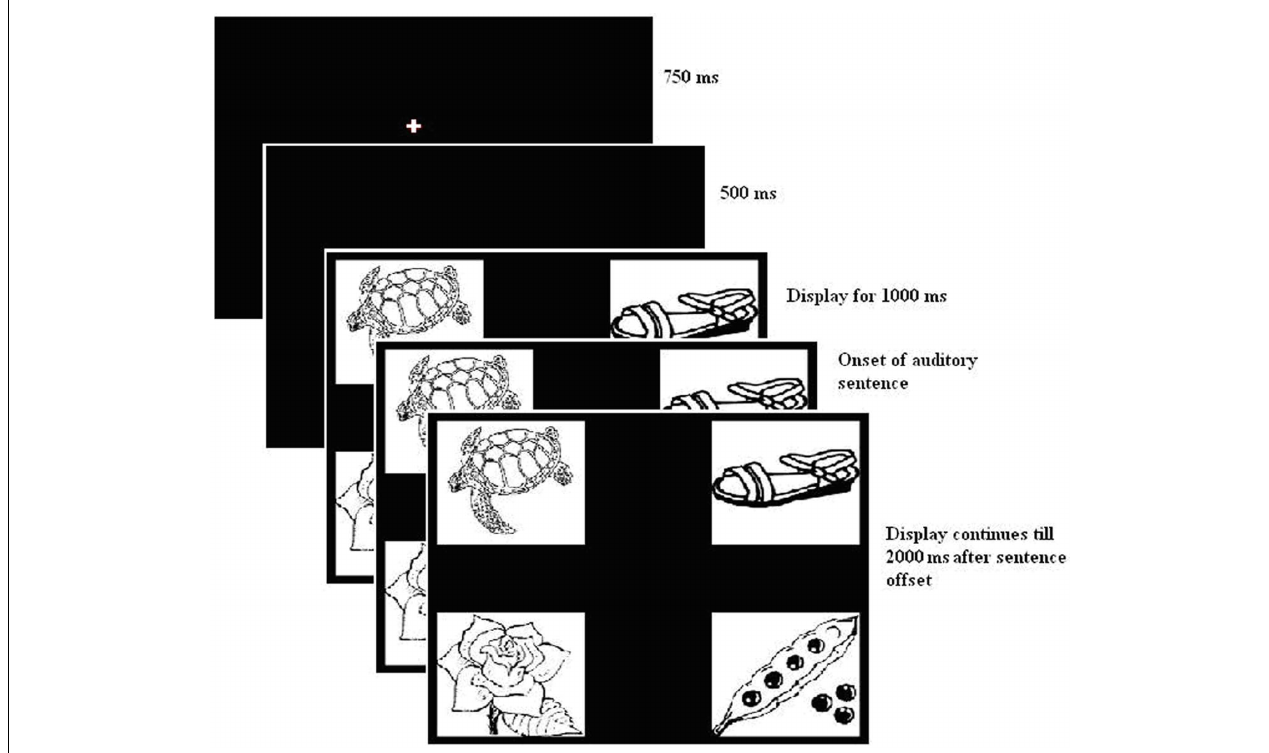
FIGURE 1 | Sequence of events during each